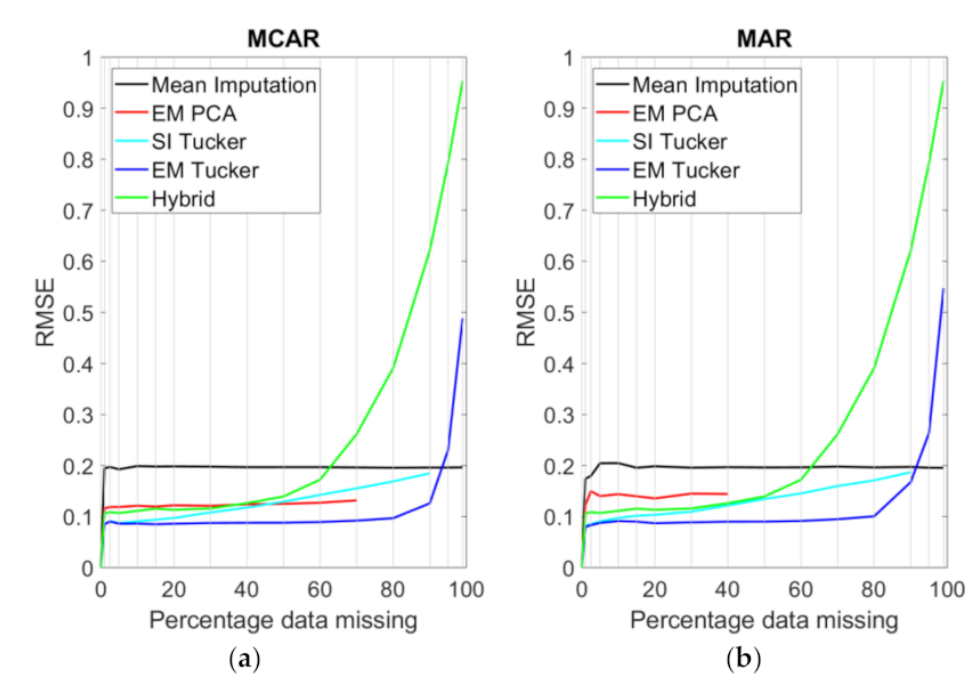
Figure 10. RRMSE for different models applied to SPAIN1. The tensor contained artificially added MCAR ( a ) and MAR ( b )